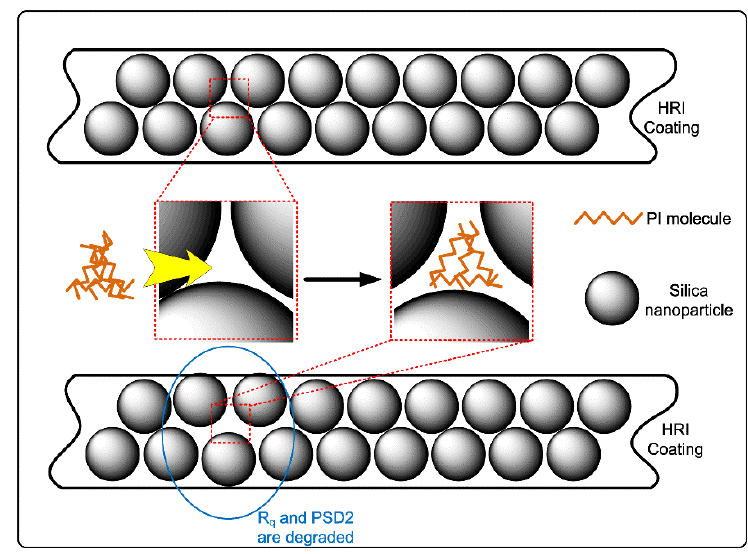
Figure 6. Schematic diagram of HRI coating deformation due to PI addition.